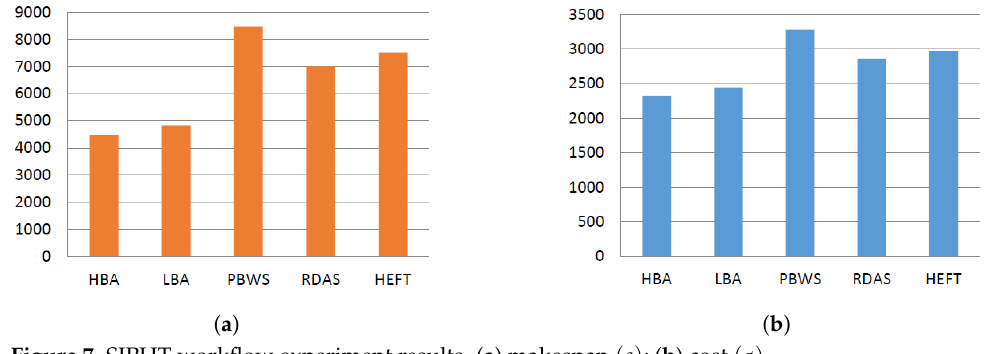
Figure 7. SIPHT workflow experiment results. ( a ) makespan ( s ) ; ( b ) cost (  )